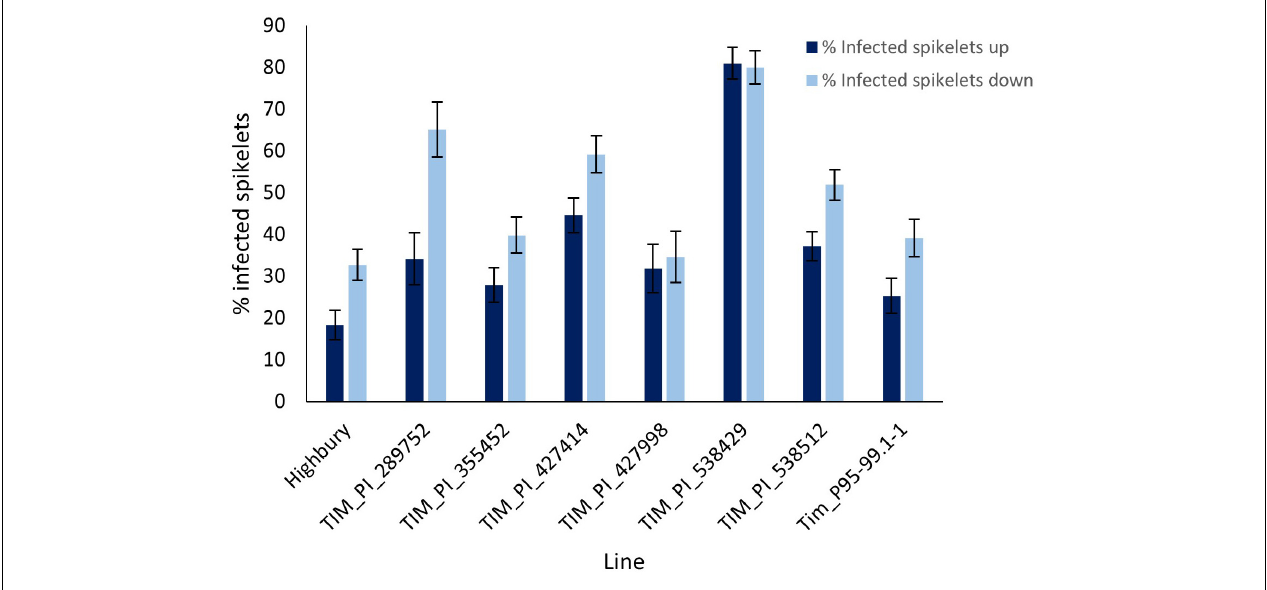
FIGURE 3 | Visual FHB disease score from 2015 trial of seven T. timopheevii accessions and Highbury susceptible control expressed as number of infected spikelets above and below the point of inoculation, 21 days post inoculation with F. graminearum (1 × 10 6 conidia per ml).